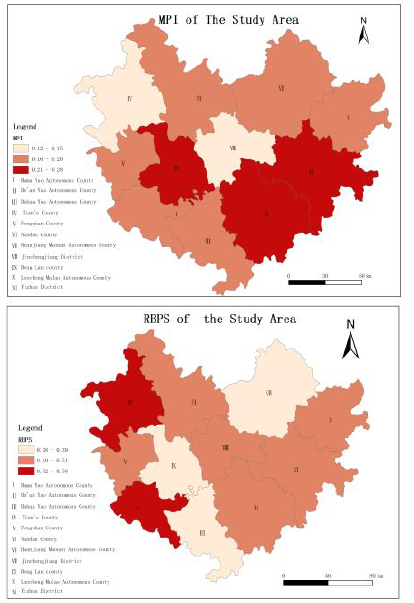
Figure 2. Spatial distribution of MPI and RBPS in the study